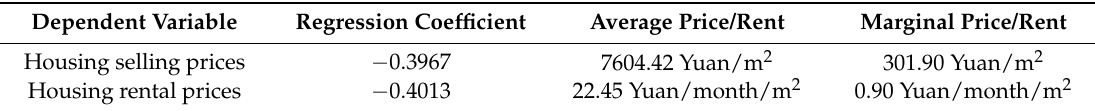
Table 7. Comparison of the effects of haze on housing selling prices and housing rental